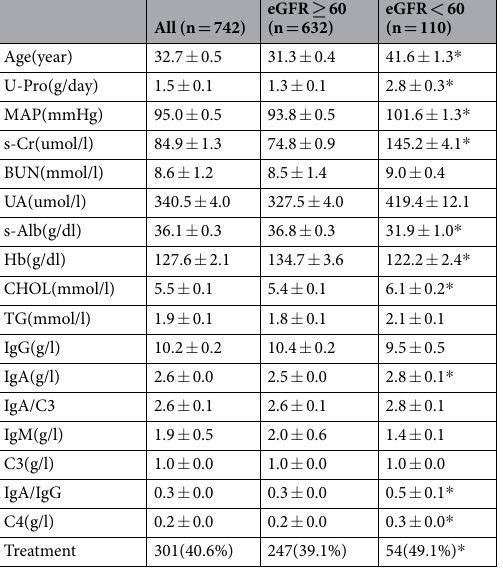
Table 1. Clinical finding among different eGFR levels at biopsy time. U-Pro, urinary protein excretion; MAP, mean artery pressure; s-Cr, serum creatinine; BUN, blood urea nitrogen; UA, uric acid; s-Alb, serum albumin; Hb, hemoglobine; CHOL, cholesterol; TG, triglyceride; Treatment: Use of ARSB or any immonosuppression; * p < 0.05 compared to eGFR ≥ 60 group.